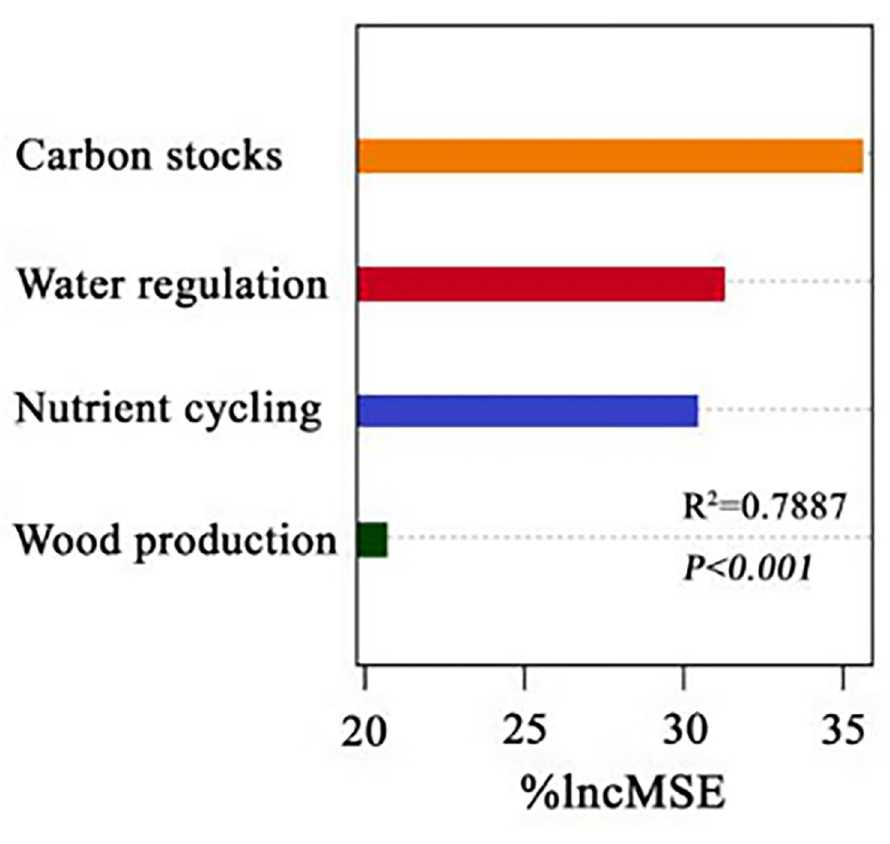
Fig 9. Functional importance ranking of single ecosystem function in arid desert